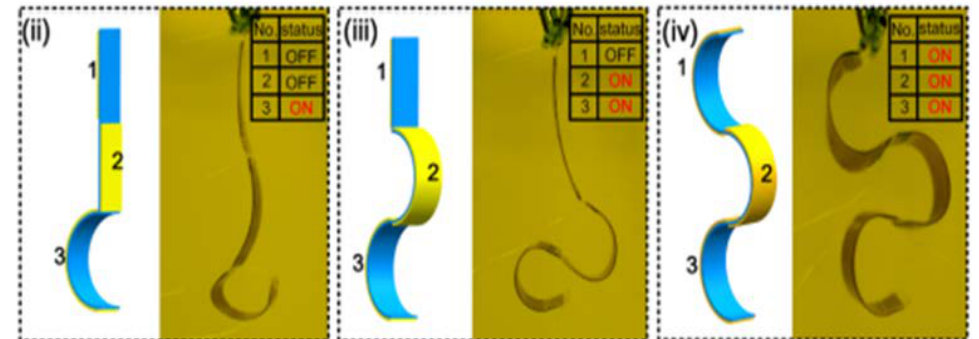
Figure 17. Three LCEs actuated by electrothermal film in series, these are controlled electronically by running more thermal energy within each of the three sections, ( ii ) shows the bottom section 3 deforming from being exposed to the electronic external stimuli. ( iii ) shows another example of actuation after previously deforming the previous section 3 within ( ii ), in ( iii ) section portions 3 and 2 have become bent due to the electronic external stimuli. ( iv ) shows the last example of all three 3, 2, and 1 becoming subjected to the electronic external stimuli and having them all deform as a result (Reprinted with permission from Liu, H., et al. [139]. Copyright 2020, American Chemical Society).